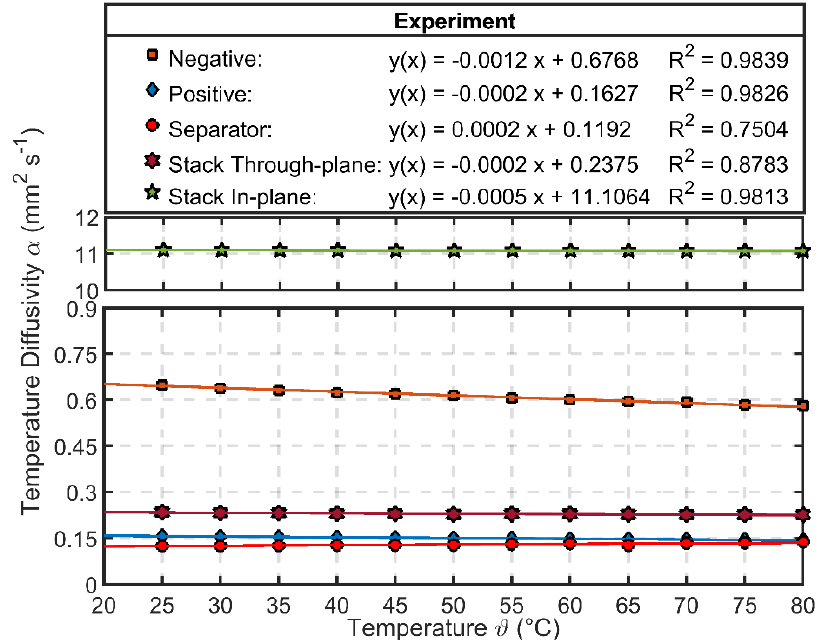
Figure 4. The in-plane α || and through-plane α ⊥ thermal di ff usivity for each electrode stack component is shown as a function of temperature ϑ ( ◦ C ) obtained from Laser Flash Analysis (LFA) measurements. Based on equation Equations (12) and (13), the e ff ective thermal conductivity variables are calculated with respect to the previous thermal characterization results. The calculated through-plane thermal conductivity k ⊥ values are within the interval 0.6 W m